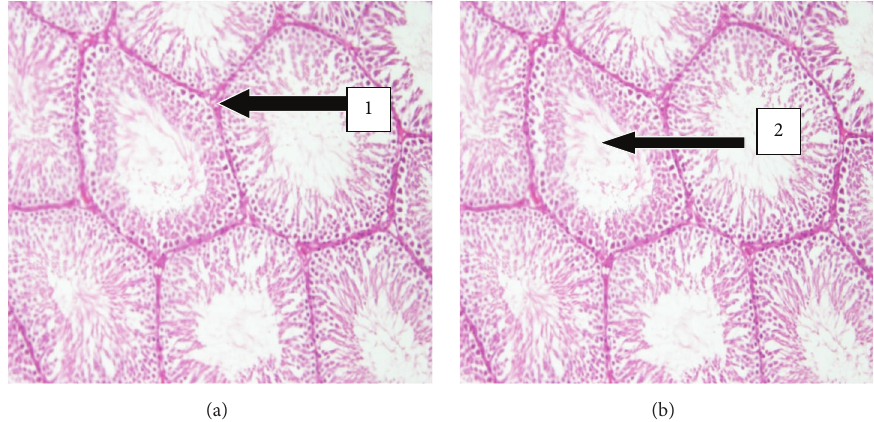
Figure 7: H&E stained sections of the testis at the magnification of 20x. (a) Testis sections of control SD rats showing normal histology. Note the presence of the intact seminiferous tubules (1) and the Sertoli cells which produces spermatozoa (2) . (b) Testis sections of treated animals (2000 mg/kg) showing normal seminiferous tubules with intact spermatogenesis.